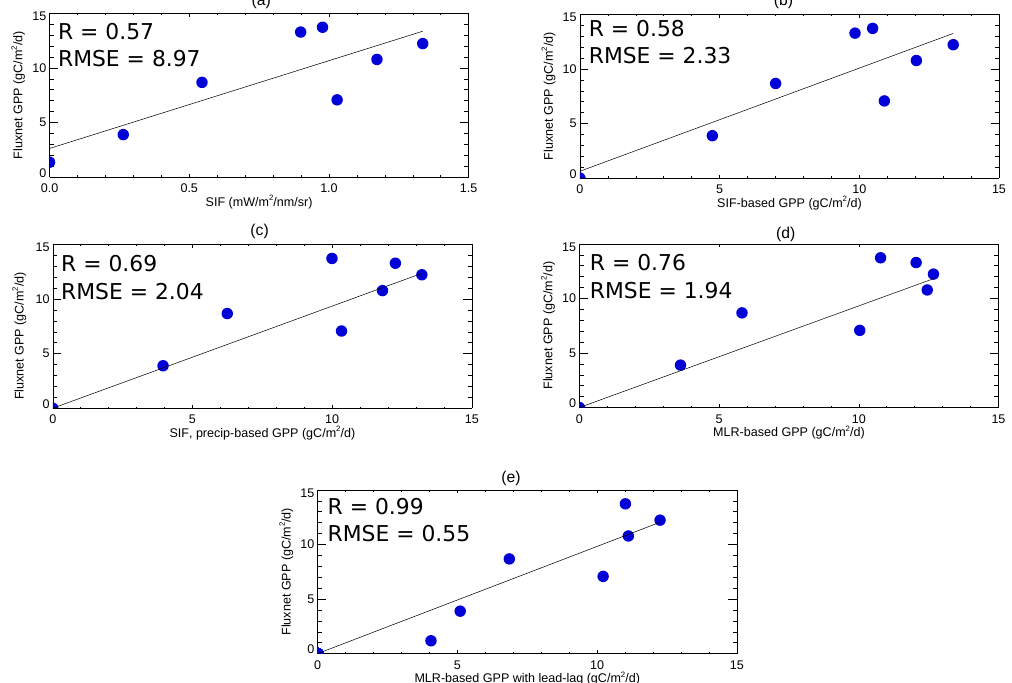
Figure 8. Relationship of mean monthly GPP (gC/m 2 /day) measured at US-Tw3 FLUXNET station characterized by alfalfa vegetation (Table 1) and ( a ) GOME-2 SIF; ( b ) SIF-based GPP; ( c ) SIF- and precipitation-based GPP; ( d ) MLR-based GPP (SIF, precipitation, soil moisture as predictors); ( e ) MLR-based GPP with lead–lag.The Spearman’s correlation coefficient R and root-mean-square error RMSE (gC/m 2 /day) are